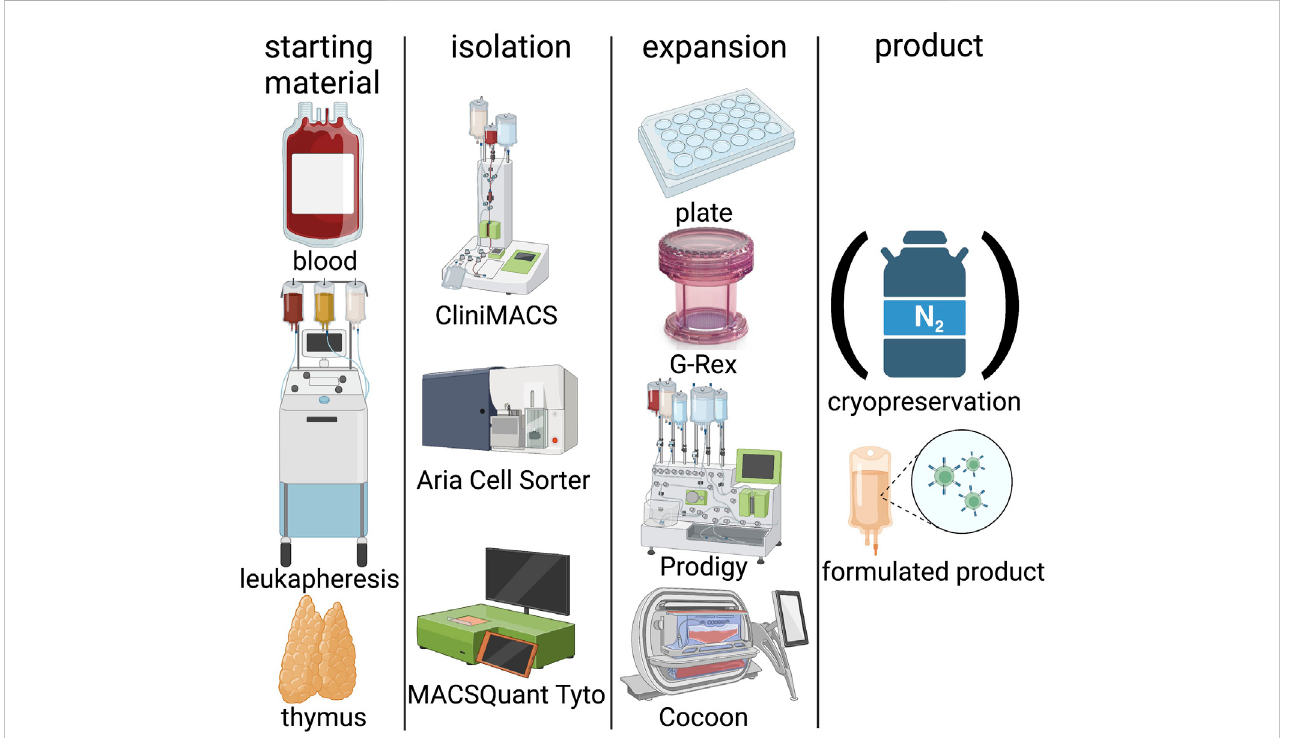
FIGURE 2 Technologies in Treg manufacturing. Blood, leukapheresis or thymi can be used as starting material. Isolation is classically performed by CliniMACS, Aria cell sorter or the more recent and GMP compliant MACSQuant Tyto system. Expansion systems include classical 24-well plates, semi-closed GRex bioreactors, orfullyclosedsystemssuchastheProdigyorCocoonplatforms.Tregproducts canbeeitherfrozeninliquidnitrogenorappliedfreshly.(Created with